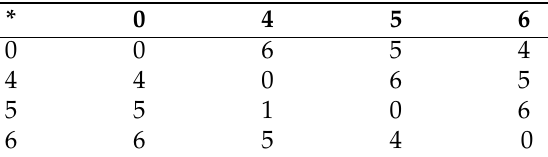
Table 3. Cayley table for the binary operation “ ∗